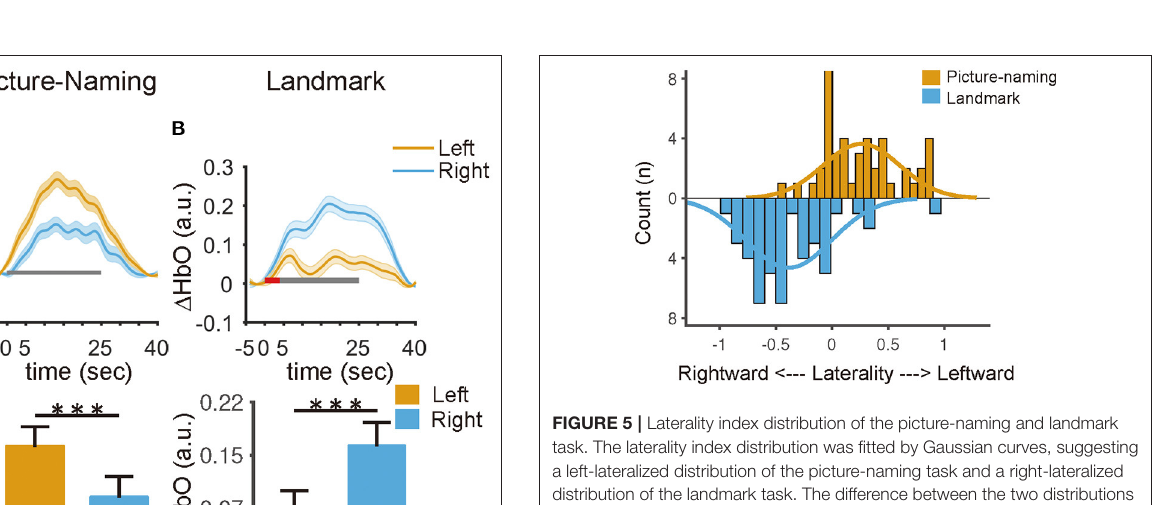
outliers in the data identified with the regstats function ( r = 0.01, p = 0.94, N = 39 ) (MATLAB, 2019a). These results indicated production to that of visuospatial attention in right-handers.